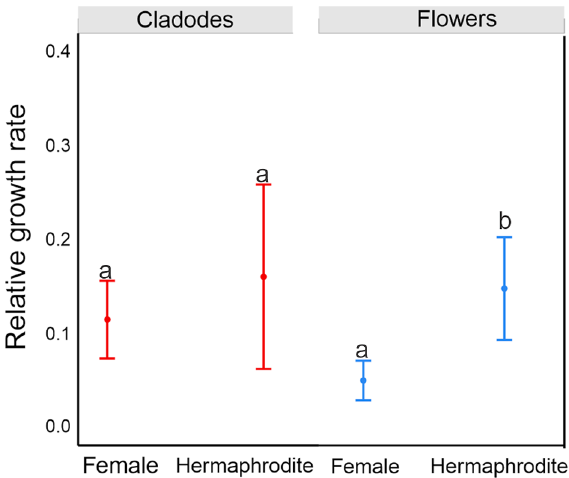
Figure 1. Effects of the sexual form (female, hermaphrodite) and structure (cladode and flower buds) of Opuntia robusta on relative growth rates of plant structures. The figure represents the estimated mean values and confidence intervals obtained from a GLM, with Gamma error distribution and a log link function. The explanatory variables were sex, type of structure, their interactions, and cumulative herbivory. The difference between female and hermaphrodite flowers was significant ( P ≤